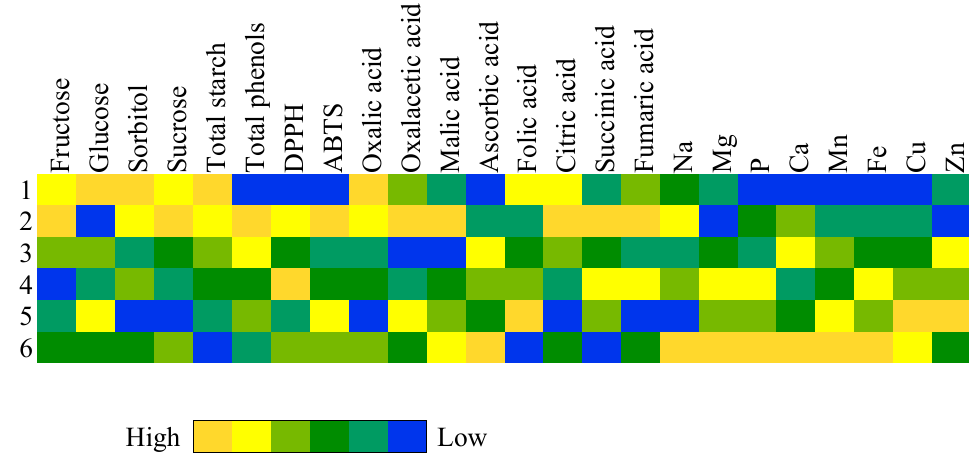
Figure 6. Relationships of agrotechnological measures according to compound concentrations in cv. Rubin apples on harvest time in average of three years. 1. Each year hand pruning forming slender spindle (control); 2. Mechanical pruning (each year); 3. Trunk incision using chain saw + mechanical pruning (each year); 4. Mechanical pruning (each year) + spraying with calcium-prohexadione; 5. Mechanical pruning + hand pruning + summer pruning; 6. Mechanical pruning one side, changing sides annually.